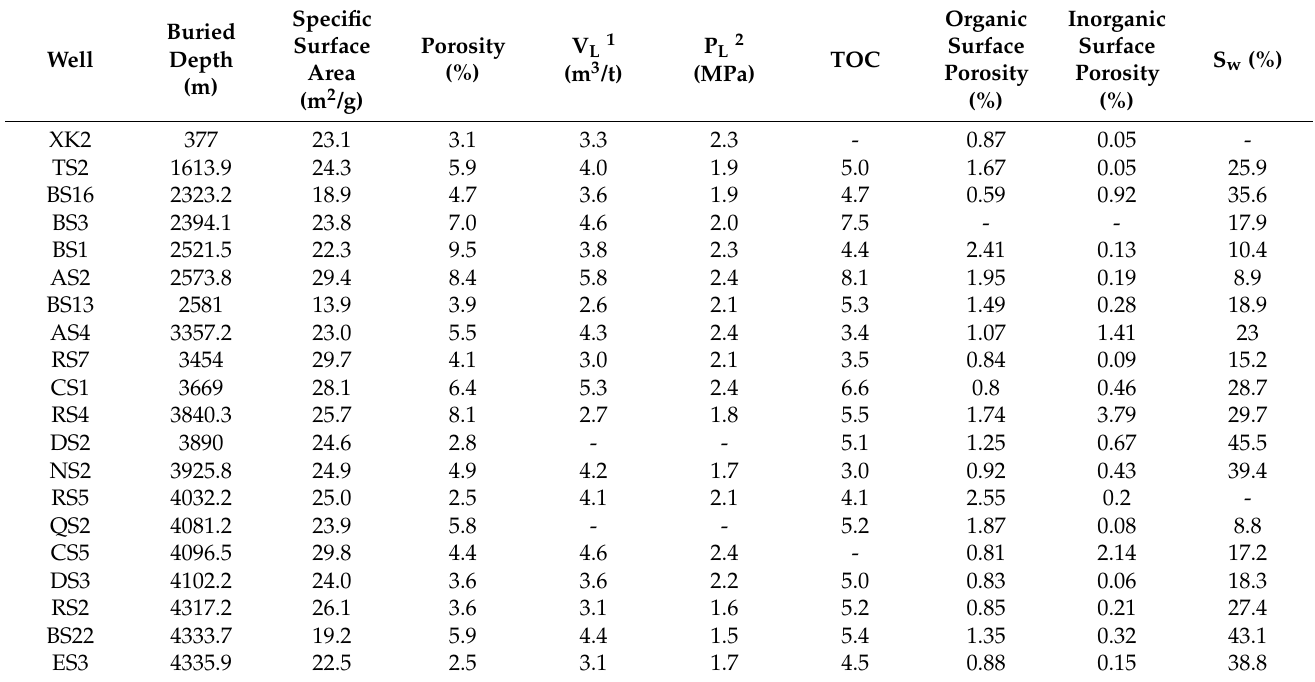
Table 2. Measured parameters for the